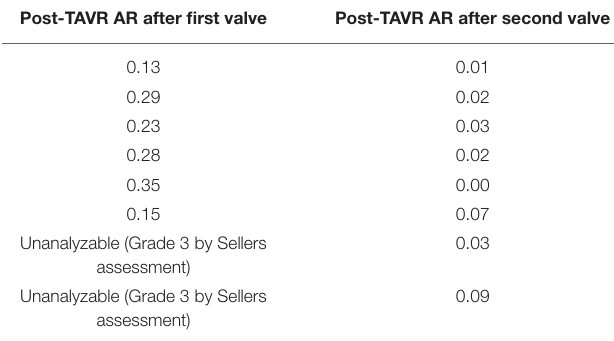
TABLE 1 | Post-TAVR AR by videodensitometric assessment in valve in valve